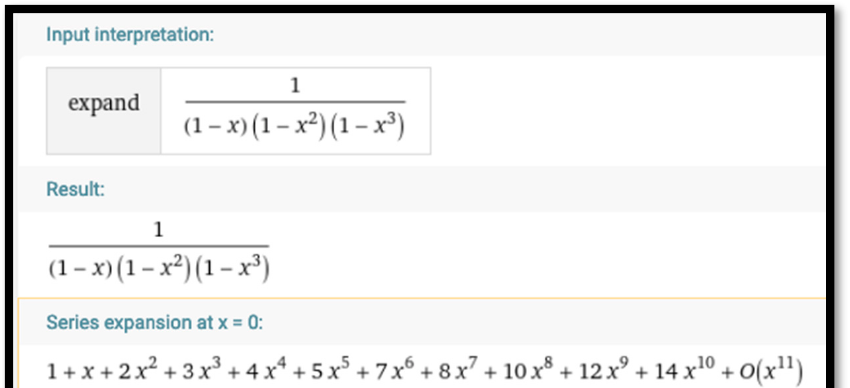
Figure 11. The generating function method as a concept-laden tool for posing a problem.